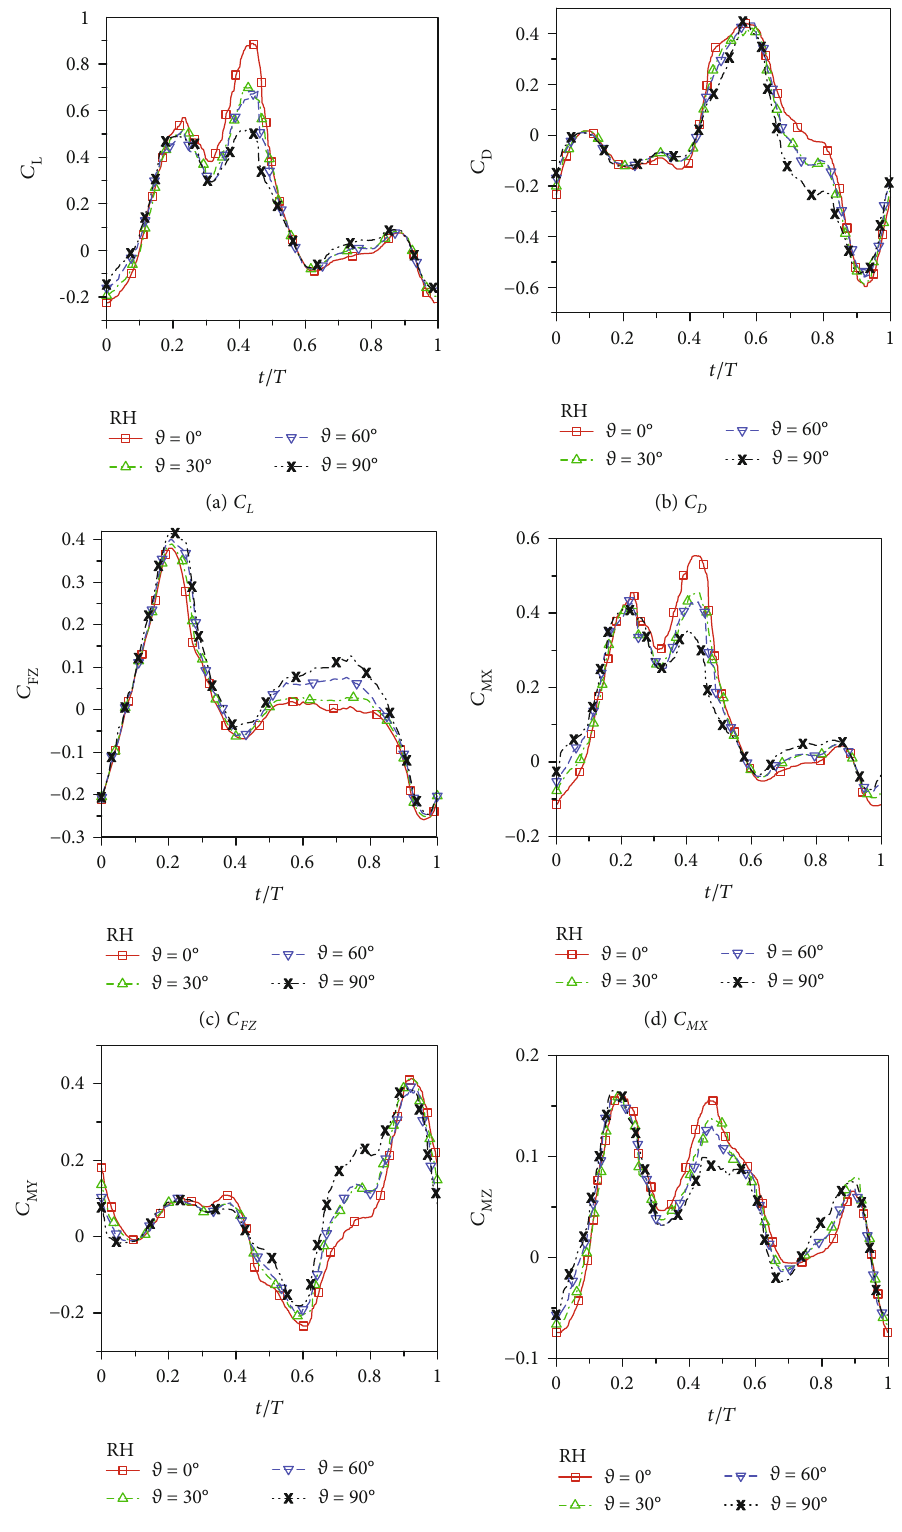
Figure 9: Coe ffi cients of instantaneous aerodynamic force and moment vs ϑ